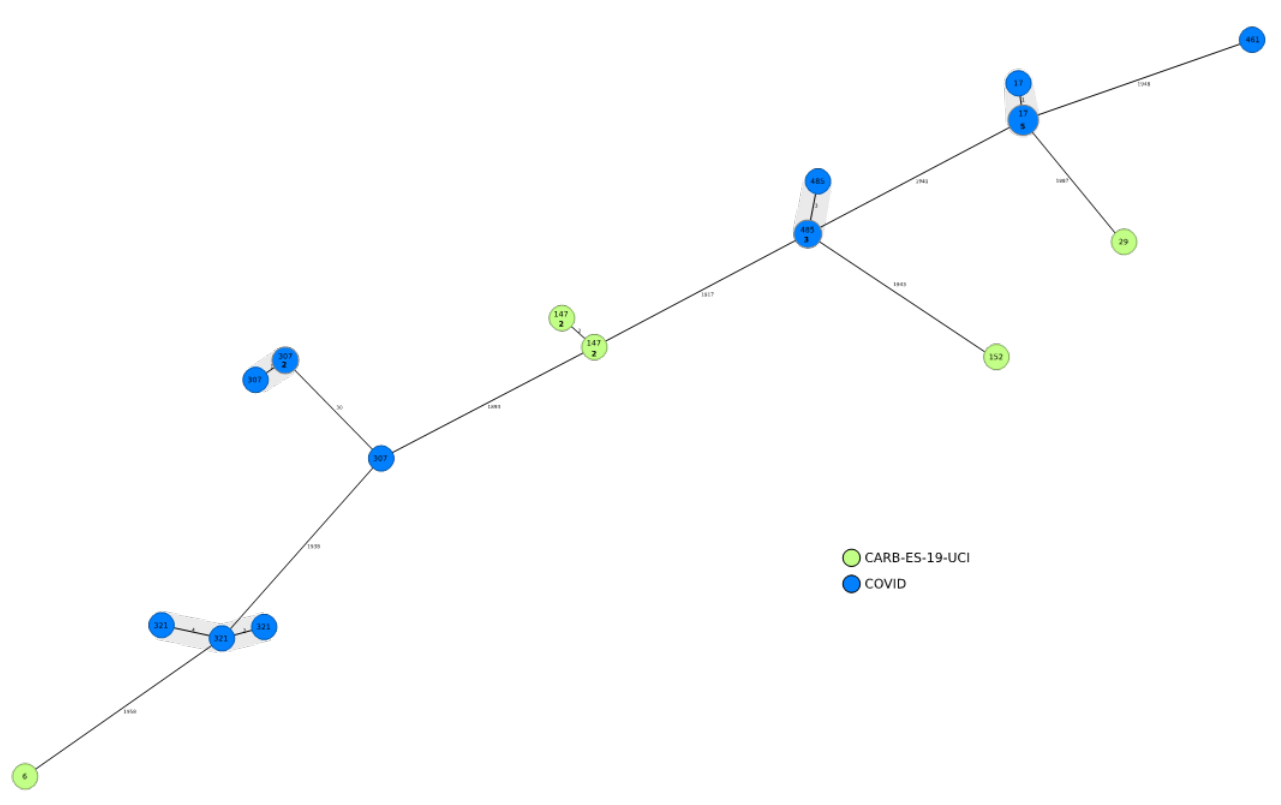
Figure 3. Population structure of VIM-1-producing Klebsiella pneumoniae in this study: Distances shown in minimum-spanning tree are based on cgMLST of 2358 genes using the parameter ‘pair- wise ignoring missing values’. Colors in each circle indicate the three study groups (COVID-19, Madrid-CARB-ES-19, ICU-CARB-ES-19) and numbers indicate the sequence type (ST). For circles that correspond to more than one isolate, the number of isolates is indicated in bold font.